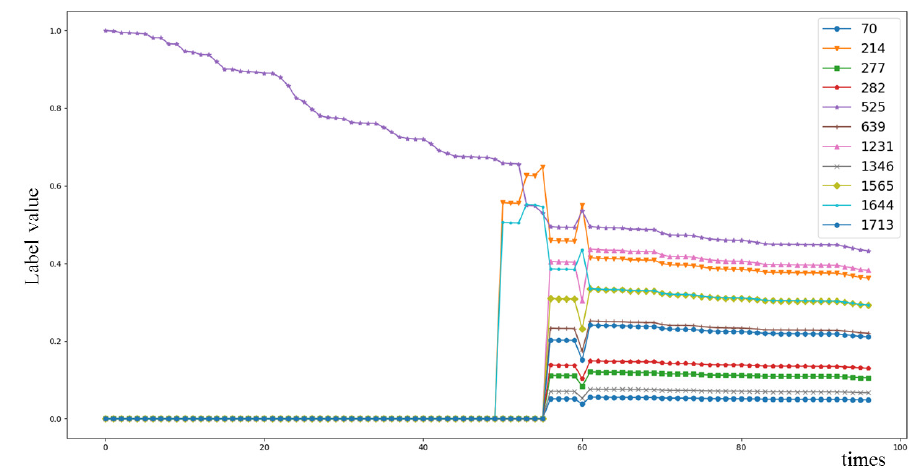
Figure 7. Label value of node 525 from 16:06:47 to 23:58:51. The horizontal axis denotes the sequence of the interactions. This sequence starts from 0 and end at 97, indicating that there are 97 information interactions between nodes in this